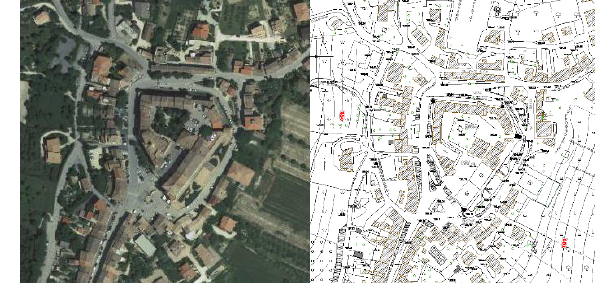
Figure 5. Orthophoto by aerial camera Z/I Imaging DMC (on the left) and 1:2000 scale digital cartography(on the right)